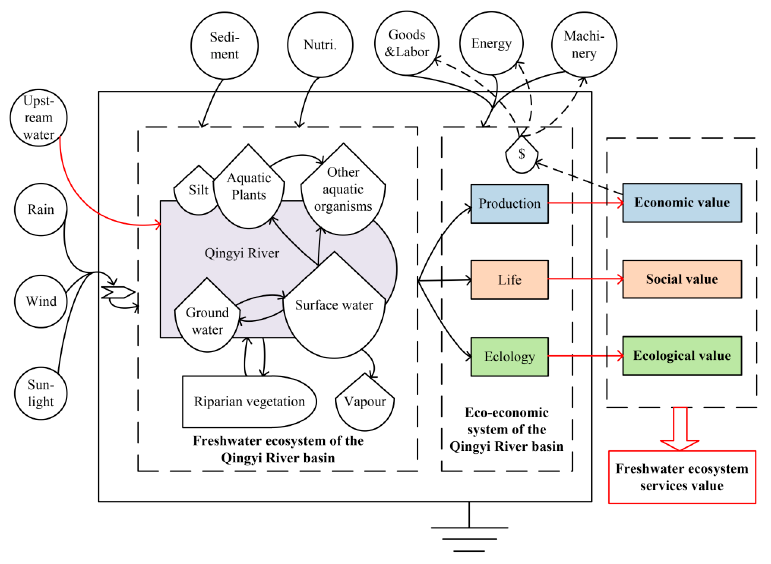
Figure 4. Energy-conversion diagram of formation process of freshwater-ecosystem-service values in Qingyi River Basin of Xuchang.